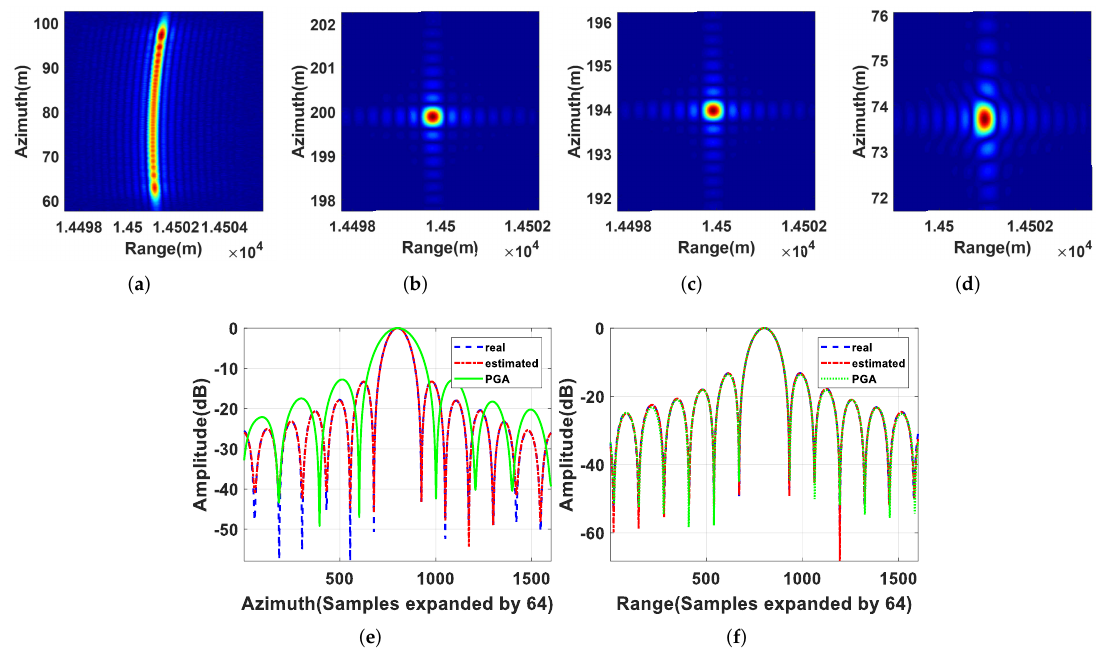
Figure 7. Refocusing results of T1: ( a ) defocusing result; ( b ) refocusing result using the real 2D velocity; ( c ) refocusing result using the estimated 2D velocity; ( d ) refocusing result using the phase gradient